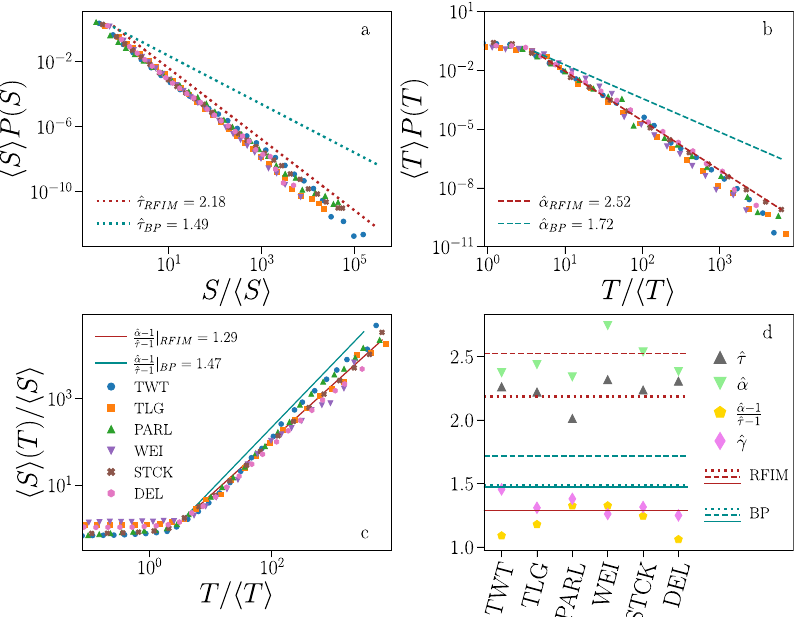
Fig. 2 Universality and criticality of information propagation in social media. a Avalanche size distribution. Different colors/symbols indicate data obtained from different social media. Acronyms are de fi ned as in Fig. 1. Dotted lines represent the maximum likelihood estimators of the exponent τ obtained by fi tting the Random Field Ising Model (RFIM), in red, and the branching process (BP), in teal. The RFIM was fi tted using N = 10 9 , R = 0.8 and considering the same number of avalanches as the Twitter sample. The BP was fi tted using n = 1.0 and sampling 10 6 avalanches. Distributions are displayed via logarithmic binning of the data. To make distributions collapse one on the top of the other, the size is multiplied by the factor 1/ 〈 S 〉 and probabilities are multiplied by the factor 〈 S 〉 . Cumulative distributions are reported in SI E. b Distribution of avalanche duration for the same data as in panel a . To make distributions collapse one on the top of the other, duration is multiplied by the factor 1/ 〈 T 〉 and probabilities are multiplied by the factor 〈 T 〉 . Dashed lines represent the maximum likelihood estimators of the exponent α obtained by fi tting the RFIM (red) and the BP (teal). c Average size of avalanches with given duration. Data are the same as in a and b . To make the curves collapse one on top of the other, the abscissa of each curve is rescaled as T / 〈 T 〉 and the ordinate is rescaled as 〈 S 〉 ( T )/ 〈 S 〉 . Solid lines represent the hyperscaling exponent ð ^ α (cid:2) 1 Þ = ð ^ τ (cid:2) 1 Þ obtained using the maximum likelihood estimators of τ and α for the RFIM (red) and for the BP (teal). d Maximum likelihood estimates of the exponents ^ τ , ^ α and ^ γ , see SI C for details. We also display the ratio ð ^ α (cid:2) 1 Þ = ð ^ τ (cid:2) 1 Þ . Error bars are always smaller than the size of the symbol. Dotted lines correspond to the best fi t of the exponent τ to the RFIM (red) and to the BP (teal), as shown in panel a . Analogously for dashed lines, representing the best fi t of α shown in b and for solid lines, representing the hyperscaling relation shown in c avalanches. Figure 2a, b shows the distributions of avalanche size and duration obtained by setting Δ = Δ * . Figure 2c shows the relation between average size and duration. The collapse of the curves relative to different data sets on a single curve hints once more, at least when data are considered at the aggregate level, to processes belonging to the same universality class.